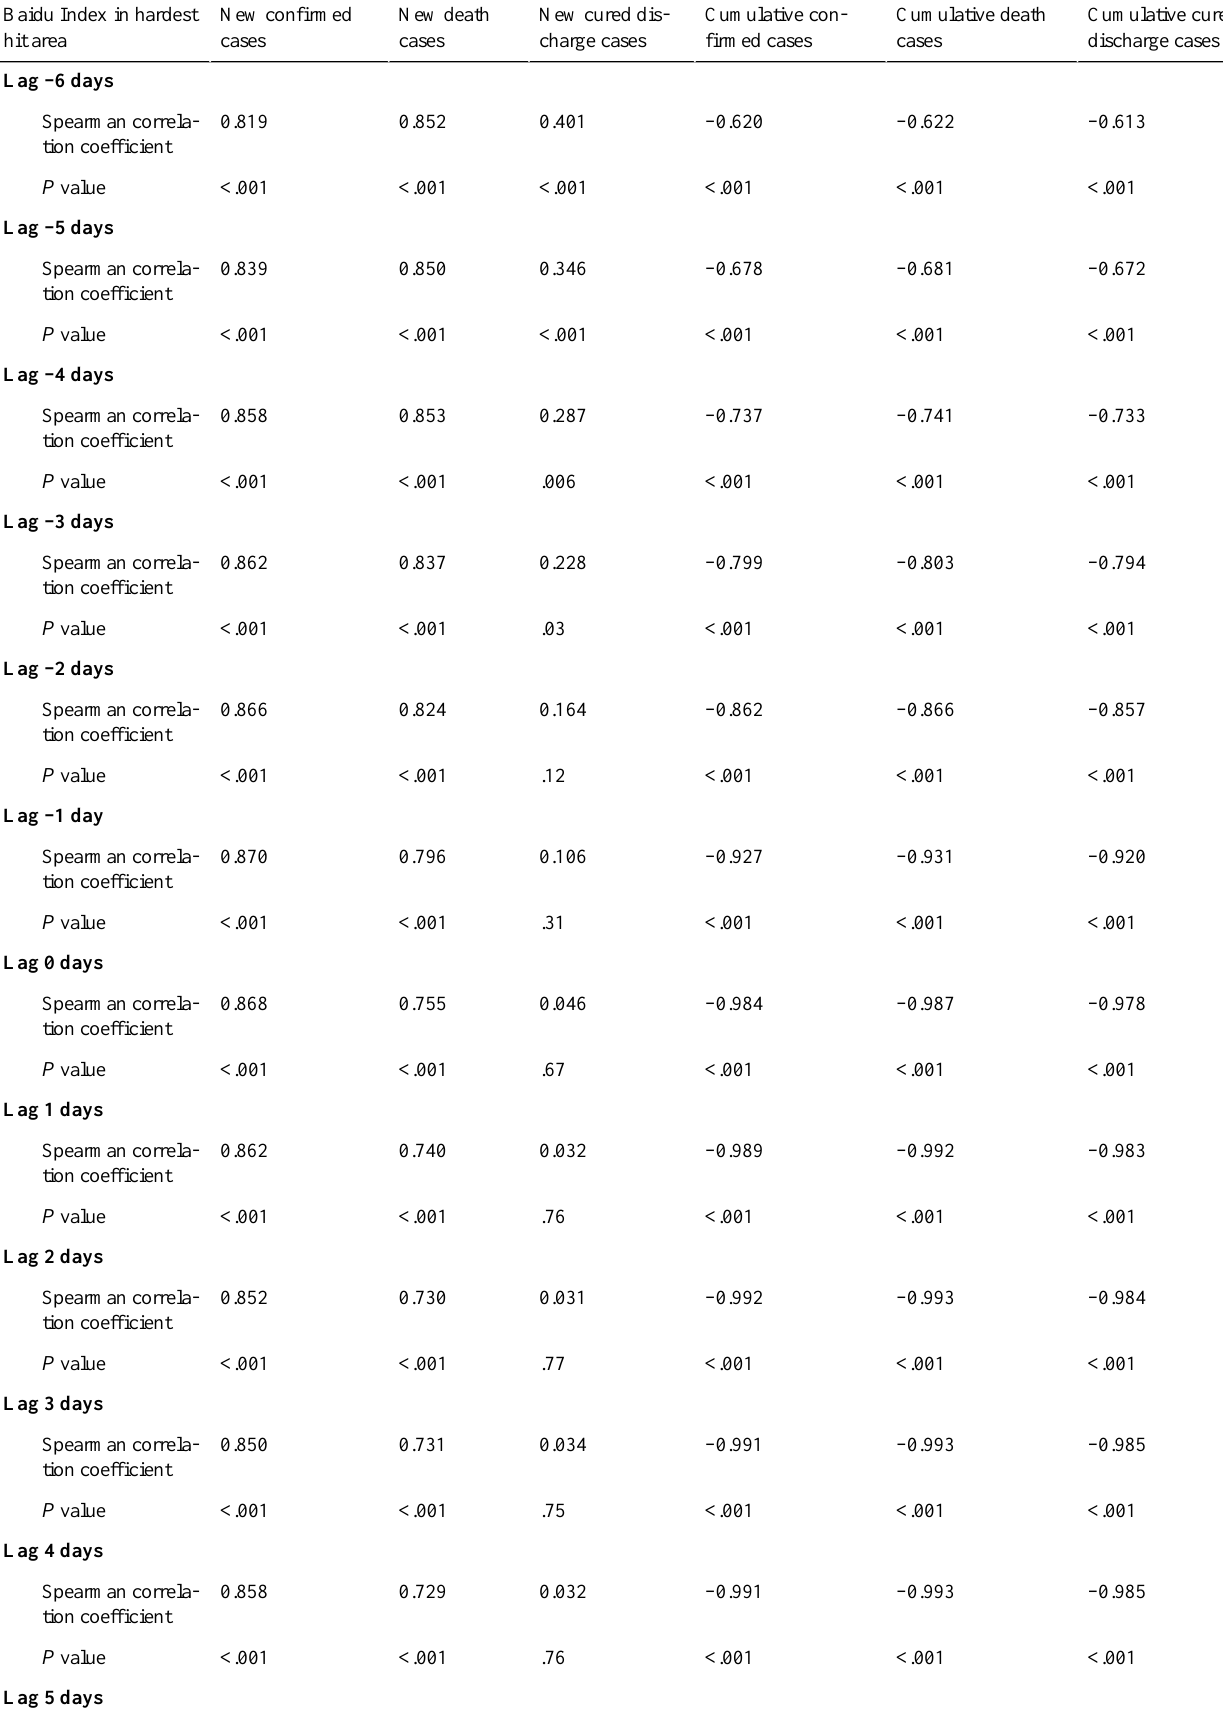
Table 3. The correlation between COVID-19 Baidu Index and real-world data from January 20 to April 20, 2020, in Hubei Province.